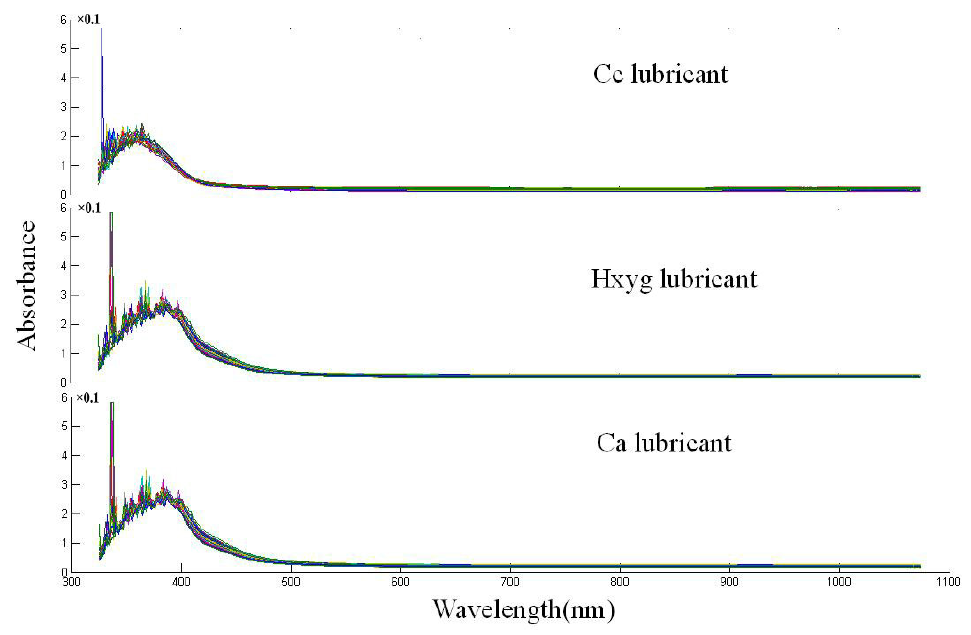
Figure 2. Vis-SWNIR spectra of three varieties of